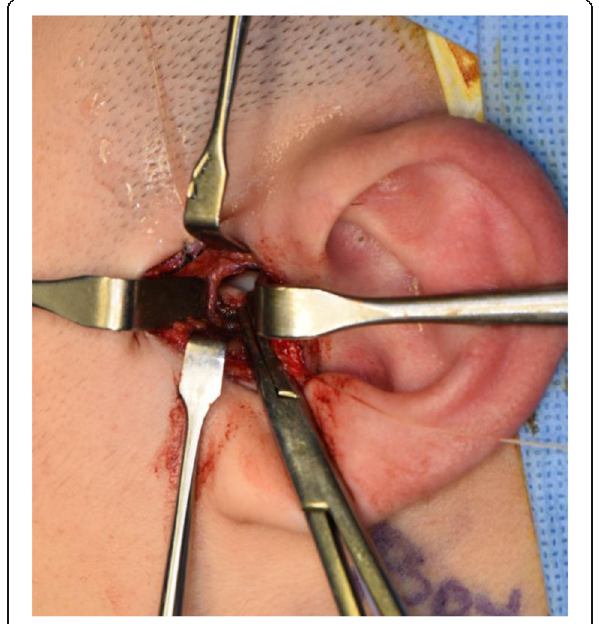
Fig. 5 Displaced disc is detached from fibrous adhesion and rotated posterolaterally to achieve the correct condyle-disc-fossa relation